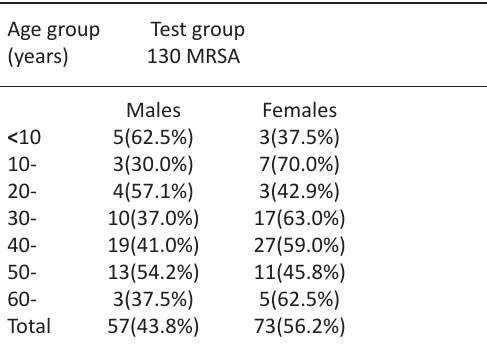
Table shows the age and gender distribution of MRSA patients. The highest overall age incidence was in the age group between 40-50